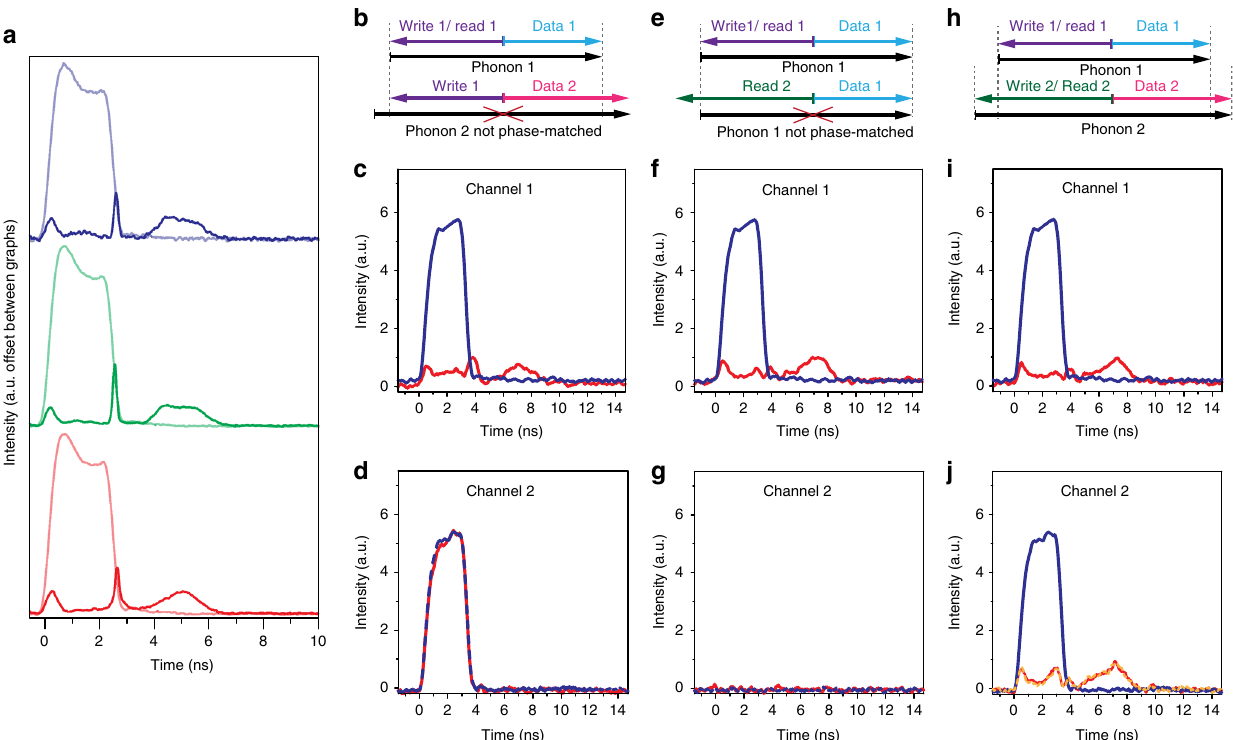
Fig. 4 Multi-wavelength operation. a Multi-wavelength operation of the photonic – phononic memory for three different laser wavelengths λ for the data pulses (thin lines) ( blue curve : 1549 nm, green curve : 1551.3 nm, red curve : 1552.9 nm). The ef fi ciency of the memory remains the same (thick lines). The Brillouin frequency shift Ω was adjusted to 7.75 GHz, 7.74 GHz and 7.73 GHz, respectively. b Phase-matching condition for two data pulses and one write pulse phase-matched to data pulse 1 (corresponds to measurement c , d ). The data pulse 2 is not phase-matched and therefore not affected by the write pulse 1. c Storage and retrieval of data pulse 1 ( blue and red curve , respectively) while data pulse 2 ( d ) in a separate channel (100 GHz away from channel 1) is unaffected ( blue dashed line : channel 1 off; red line : channel 1 stored and retrieved). e Phase-matching condition for two separate read pulses with data pulse 1 (corresponds to measurement f , g ). One can see that read pulse 2 cannot readout phonon 1. f Shows the writing and retrieving of a data pulse ( blue and red curve , respectively) in channel 1 while at the same time no readout pulse can be seen in channel 2 ( g ; blue dashed line : channel 1 off; red line : channel 1 stored and retrieved). h Phase-matching condition for two channels operating at two different wavelengths. i Storage and retrieval of data in channel 1 while simultaneously storing and retrieving data in channel 2 ( j ) ( blue and red curve , respectively). For comparison the storage and retrieval of only channel 2 is depicted by the dashed orange line in j . Note: the difference in the noise fl oor between channel 1 and channel 2 is caused by the different noise properties of the two different